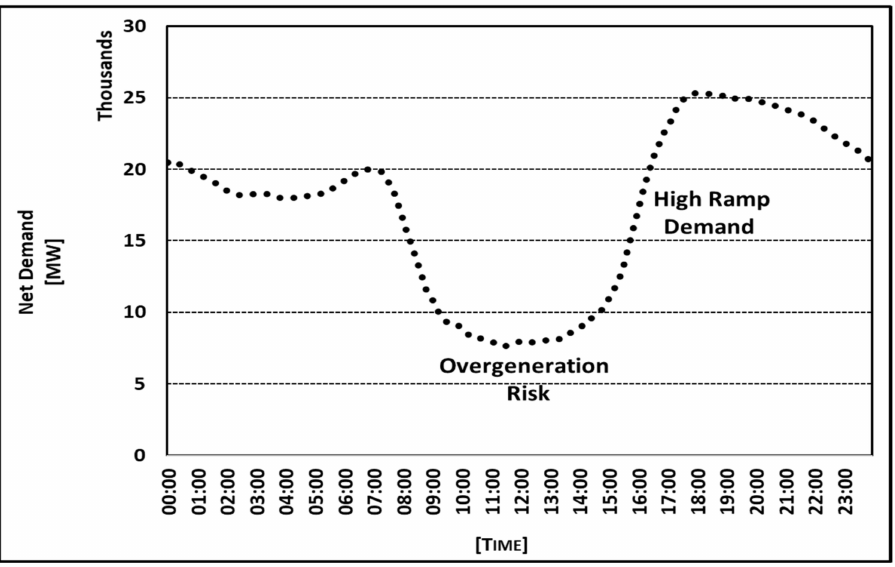
Figure 13. California’s Duck